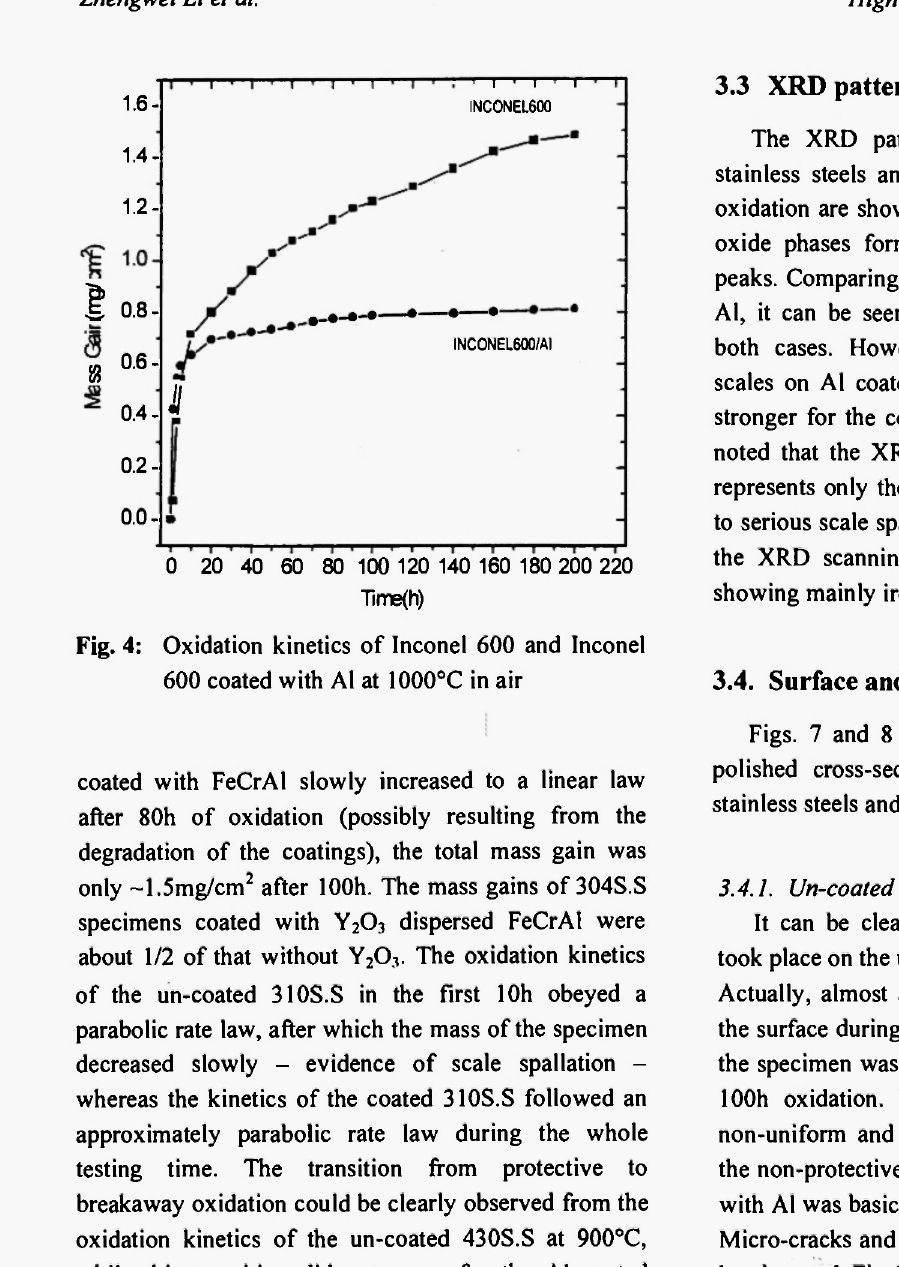
coated with FeCrAl slowly increased to a linear law after 80h of oxidation (possibly resulting from the degradation of the coatings), the total mass gain was only ~1.5mg/cm 2 after 100h. The mass gains of 304S.S specimens coated with Y 0 dispersed FeCrAl were 2 3 about 1/2 of that without Y 0 . The oxidation kinetics 2 3 of the un-coated 310S.S in the first 10h obeyed a parabolic rate law, after which the mass of the specimen decreased slowly - evidence of scale spallation - approximately parabolic rate law during the whole testing